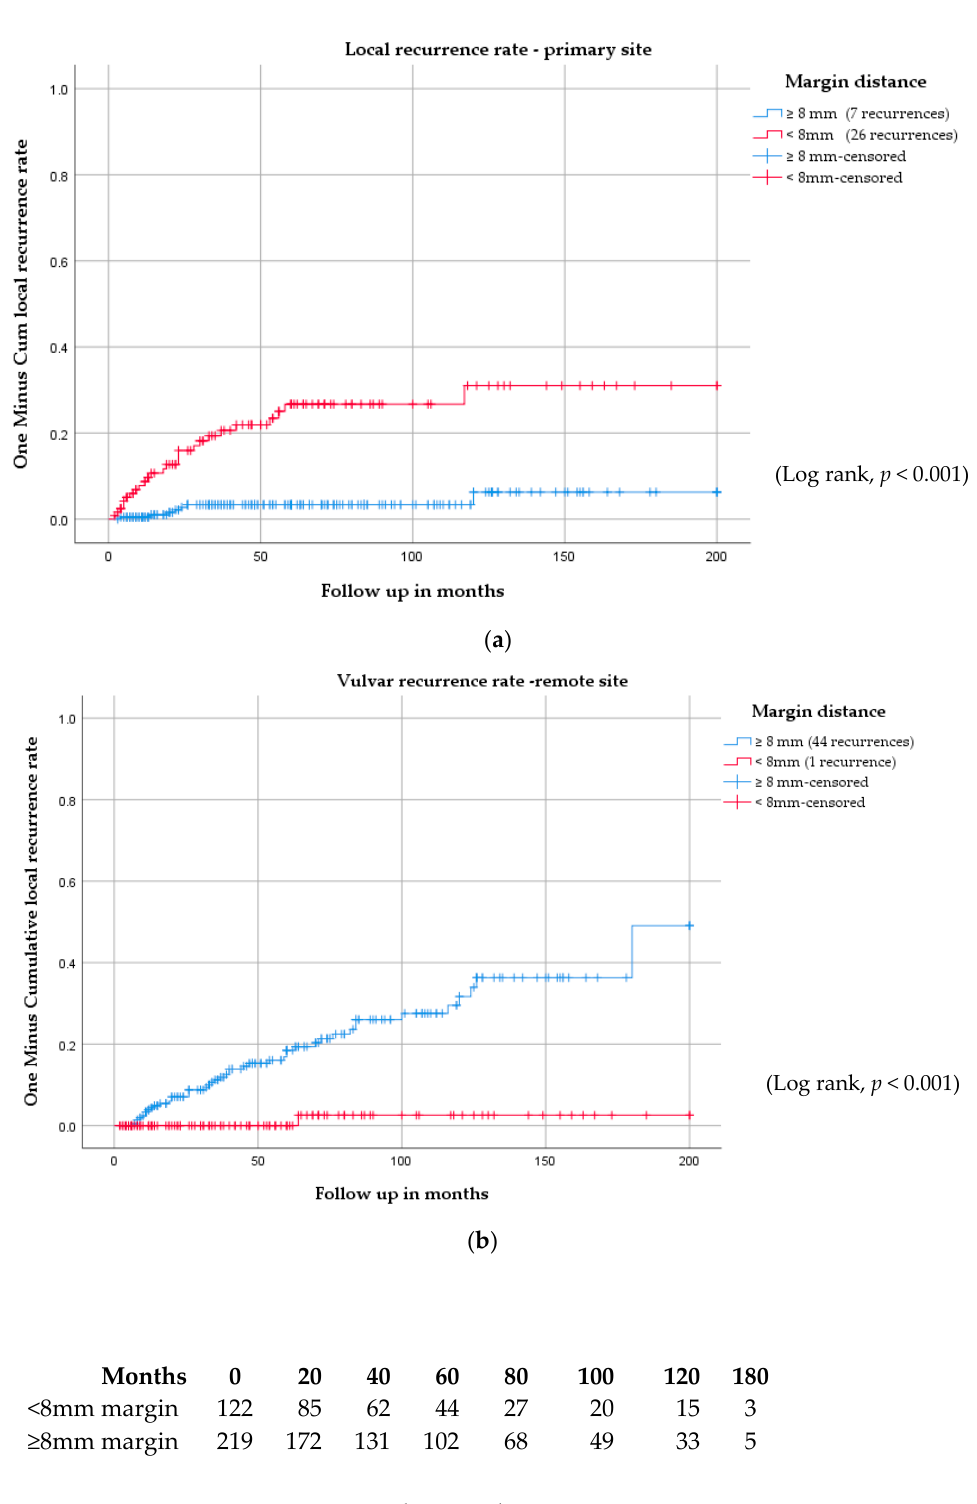
Figure 4. Vulvar recurrence rate for ( a ) the primary site and ( b ) the remote site stratified by surgical margins of <8 mm and ≥ 8 mm.